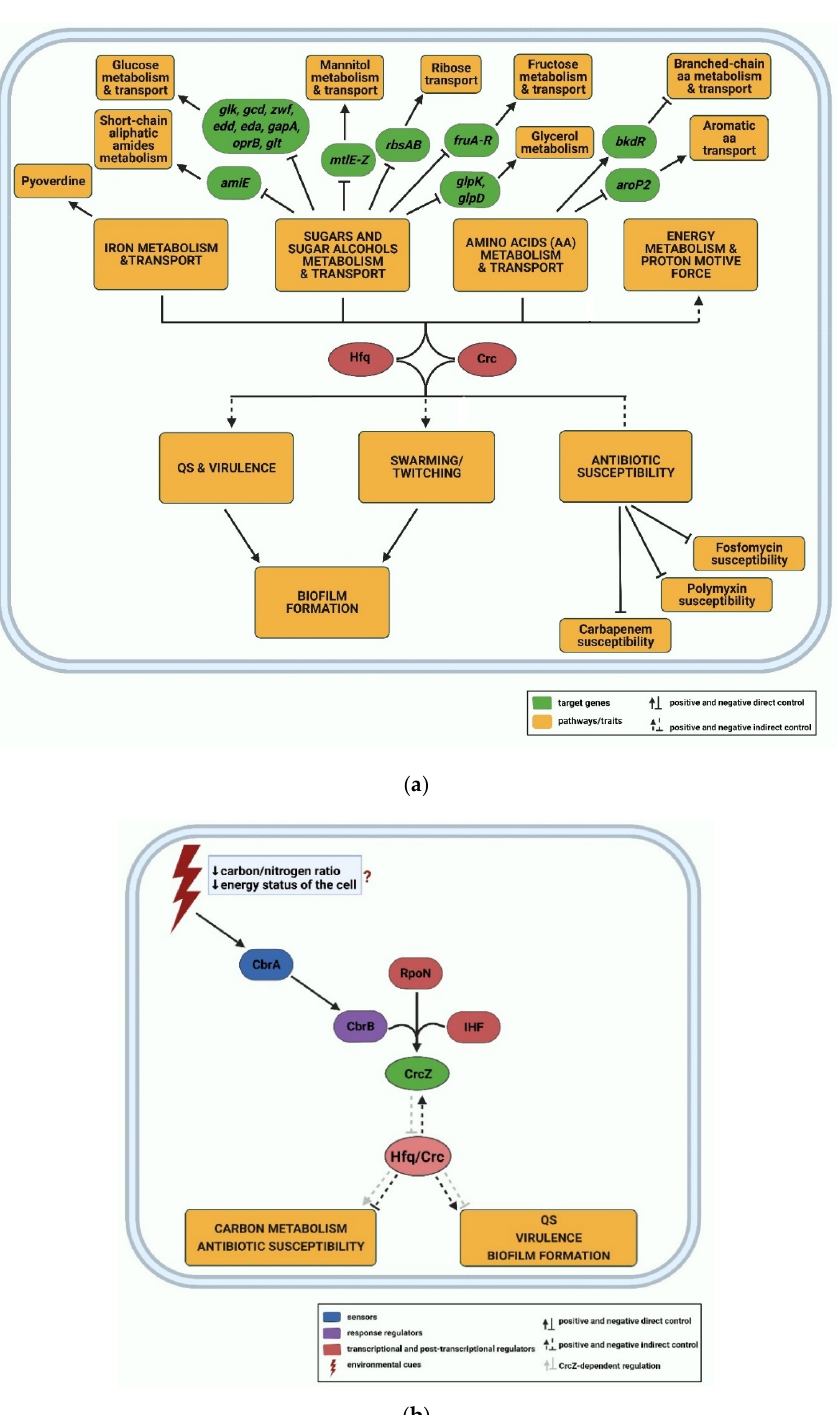
Figure 3. ( a ) The Hfq/Crc regulon. Hfq and Crc can exert translational repression of genes involved in carbon, iron and energy metabolism (top). In addition, they are implicated in direct (straight lines) or indirect (dashed lines) regulation of QS, virulence, antibiotic susceptibility and biofilm formation (bottom). The scheme was drawn based on previous reports [142,147,150,170–172]. ( b ) Transcription and stability of CrcZ RNA. The CrcZ RNA can compete for Hfq and/or Hfq/Crc repressive complexes, and thereby cross-regulate physiological processes involved in carbon metabolism and virulence (light grey lines; ( a )). The synthesis of CrcZ RNA occurs under energy-limiting conditions in the presence of an unfavorable carbon source by the joint action of the CbrA/B TCS, which is activated by a yet unknown signal (red question mark), IHF and sigma factor RpoN, ↓ : positive control; ⊥ : negative